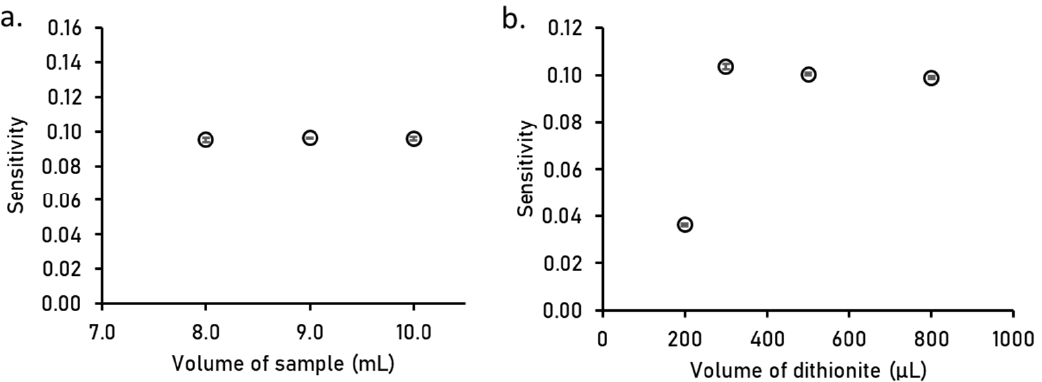
Figure 5. Investigation of ( a ) sample volume and ( b ) reagent volume for paraquat analysis. Experimental conditions: 0.50 mL of color-forming reagent solution, 1000 rpm of stirring speed, and 30 s stirring time.